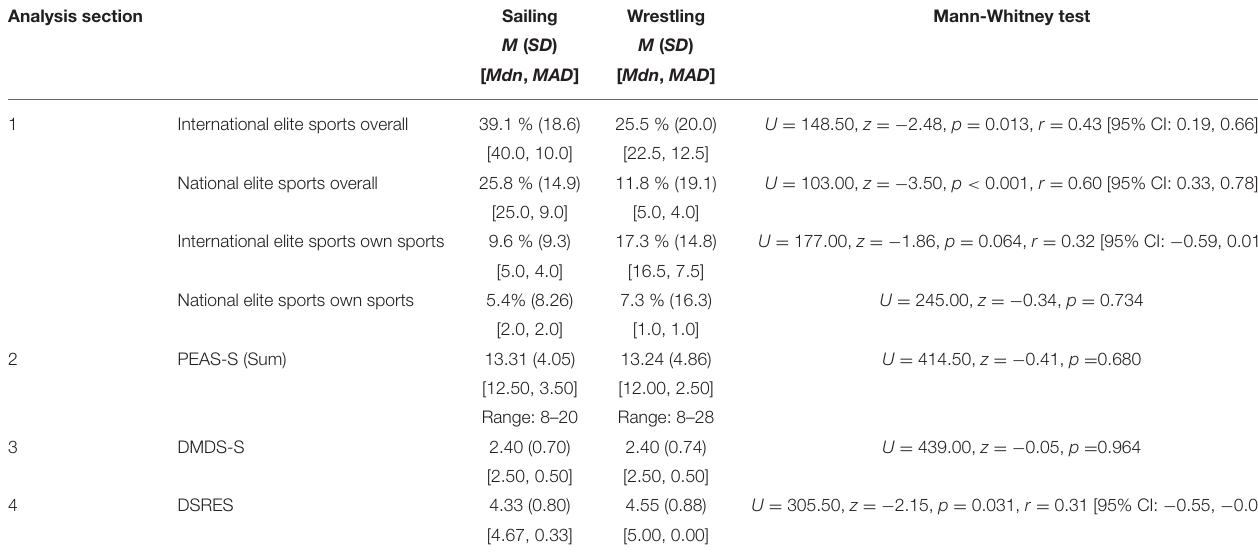
TABLE 2 | Comparison of athletes from sailing and wrestling concerning their prevalence estimations as well as doping attitudes (PEAS-S), moral perspective (DMDS-S), and resistance against doping (DSRES). Analysis